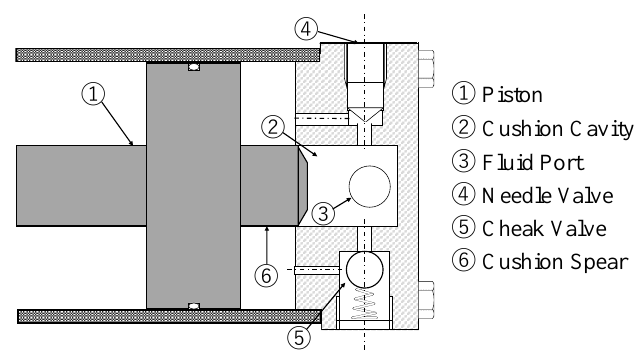
Figure 1. Schematic View of Dumper Cylinder.